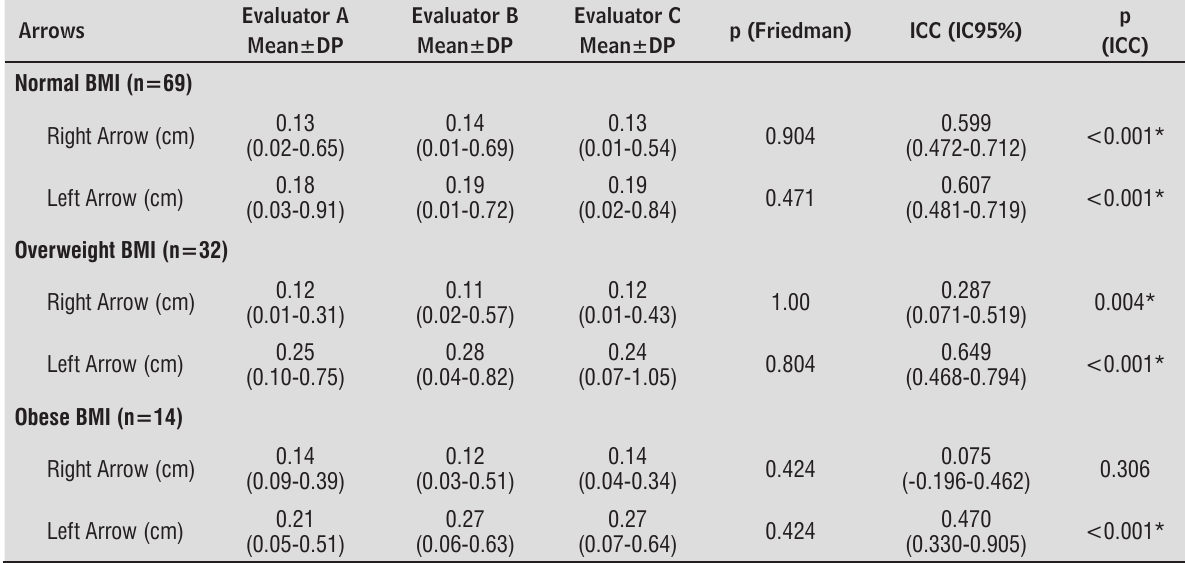
Table 2 - Results of the Vert 3D Version 1 regarding to the inter-rater reproducibility of the scoliosis arrows in the various nutritional profiles